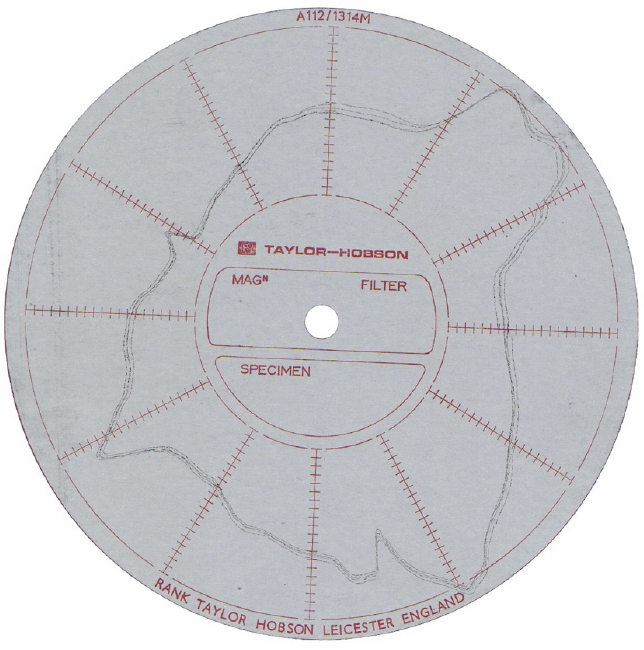
Figure 8. Centering error: eccentricity and roughness errors of the SMR sphere (2 µm scale). The incidence angle of the laser beam contributes to the measurement uncertainty.